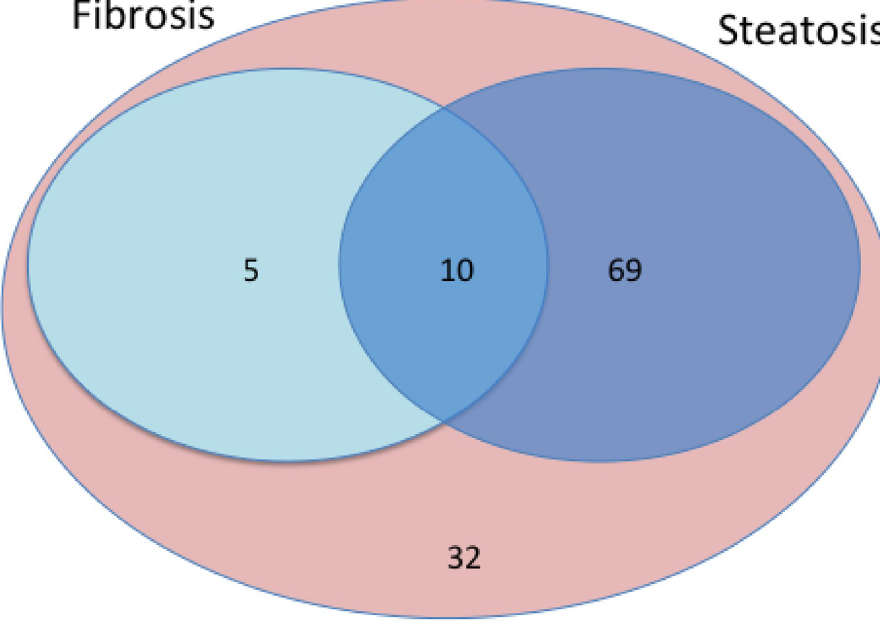
Fig 1. Study cohort. The Venn-diagram depicts the number of patients with relevant fibrosis (n = 5) or relevant steatosis (n = 69 patients) or both (n = 10), measured by Fibroscan. Thirty-two patients had neither relevant fibrosis, nor steatosis. The total of 116 patients was included into the